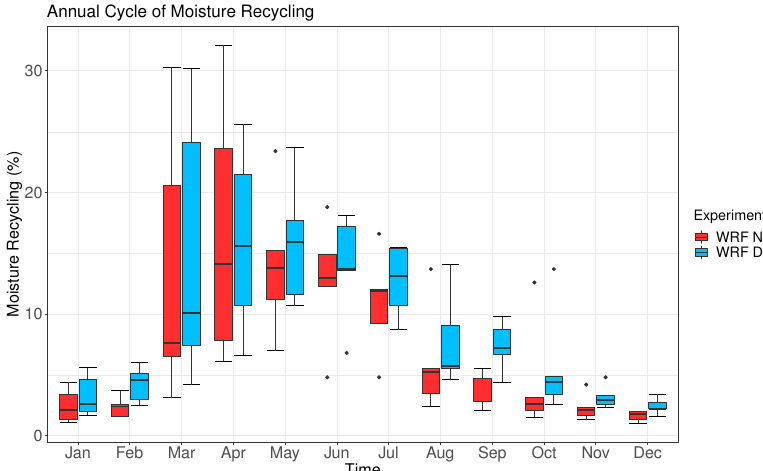
Figure 3. Annual cycle of moisture recycling over the IP for both WRF simulations: WRF N in red and WRF D in